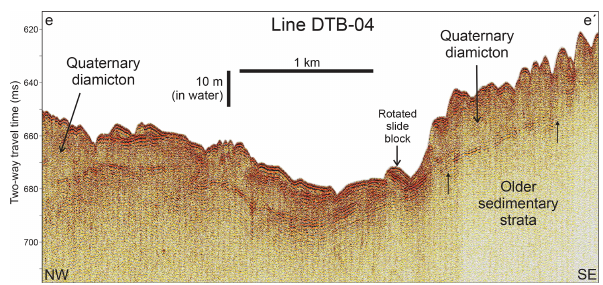
Figure 6. Part of DTB Line 4 across the step-sided basin that lies closest to the trough confluence. The profile shows an acoustically transparent layer of variable thickness, interpreted as Quaternary diamicton, overlying a strong reflector, interpreted as an unconfor- mity above older sedimentary strata. Short segments of truncated, dipping reflectors, marked by upward-pointing small arrows, can be seen beneath the strong reflector at the base of the acoustically transparent layer. Two-way travel times have been corrected for the tow depth of the boomer so that they represent approximate times from the sea surface. Location of profile shown in Fig. 5a.